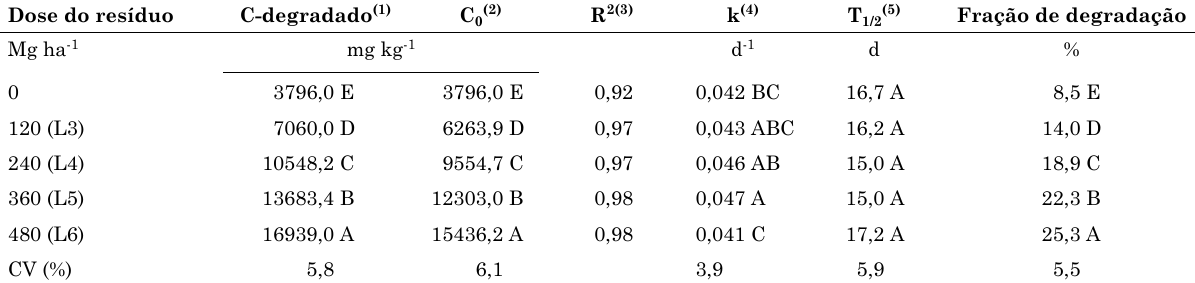
Quadro 3. parâmetros da equação de cinética de primeira ordem ajustados aos dados de liberação de co 2 do tratamento com lodo de esgoto no ensaio ii e fração de degradação, em ensaio realizado em